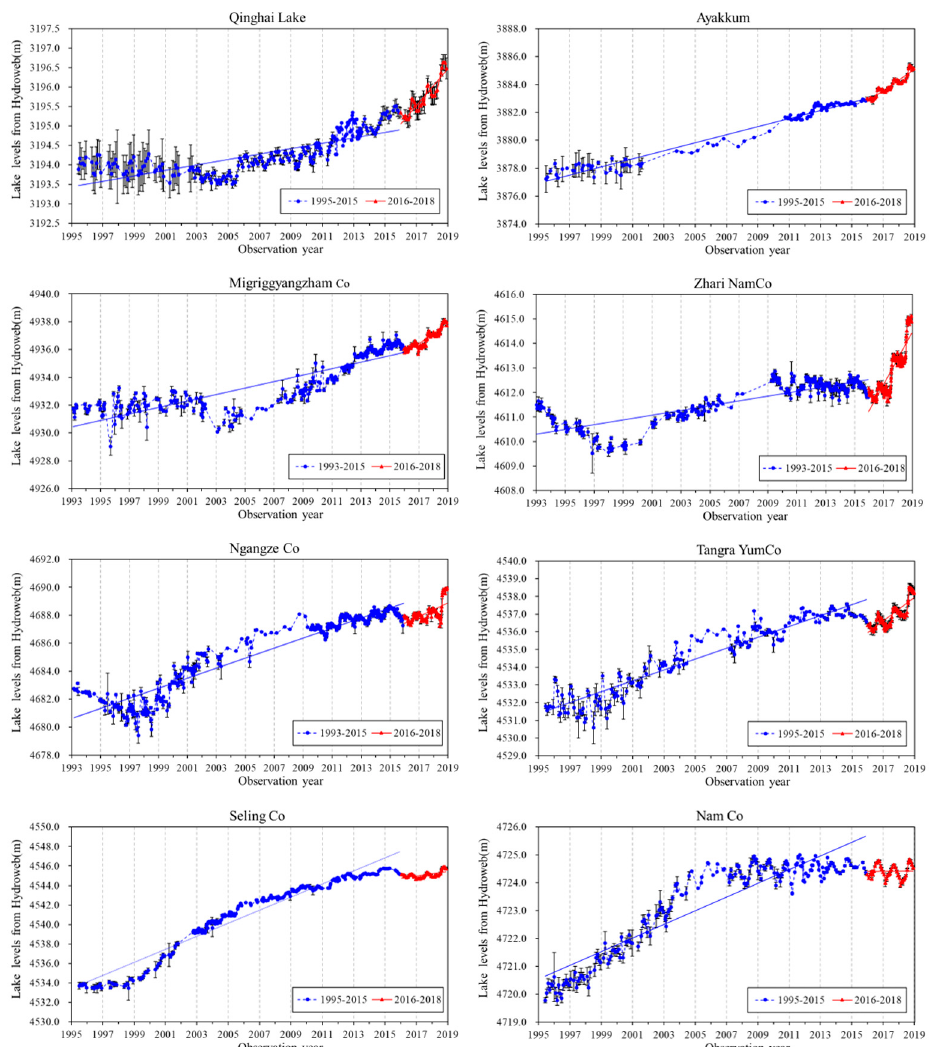
Figure 4. Long-term lake level variations of eight large lakes in the TP during 1995–2018 based on the Hydroweb and DAHITI altimetry data archives.